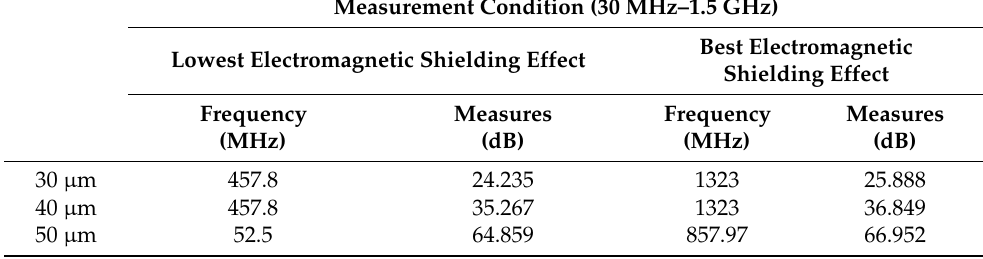
Table 3. Comparison of electromagnetic shielding